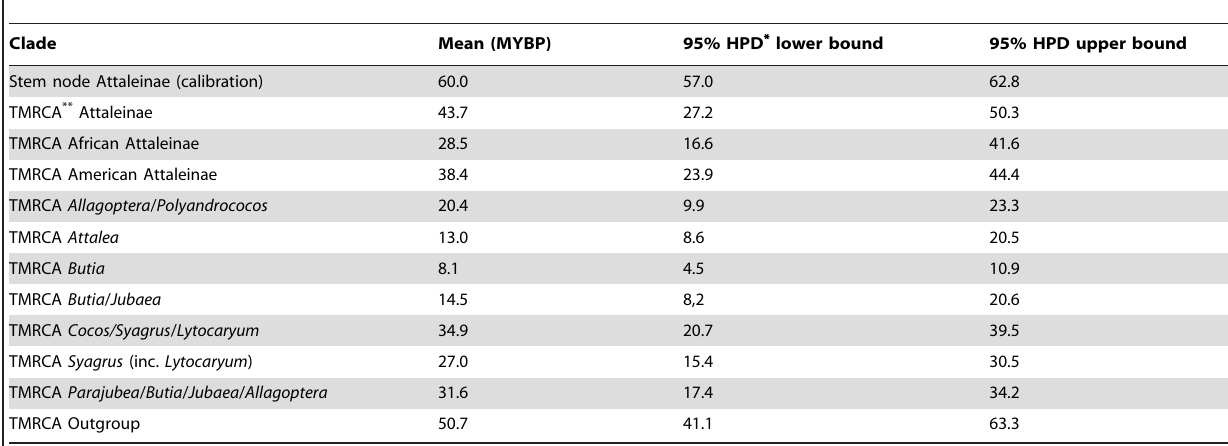
Table 5. Estimated divergence dates for selected clades within Cocoseae subtribe Attaleinae.